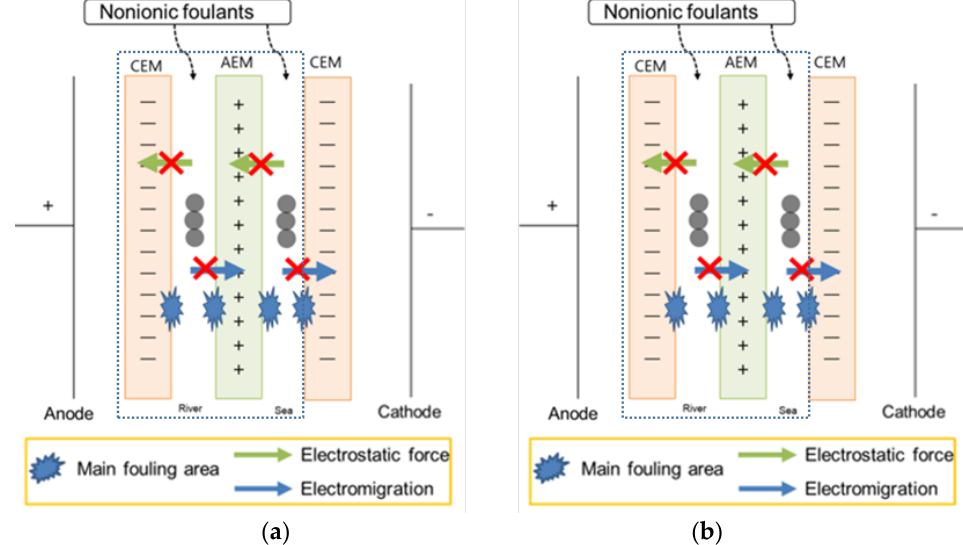
Figure 8. Illustration of showing ( a ) the hypothesis and ( b ) the experimental result of the RED system with only one cell pair (the part within the dashed square) supplying seawater and river containing non-charged foulants.